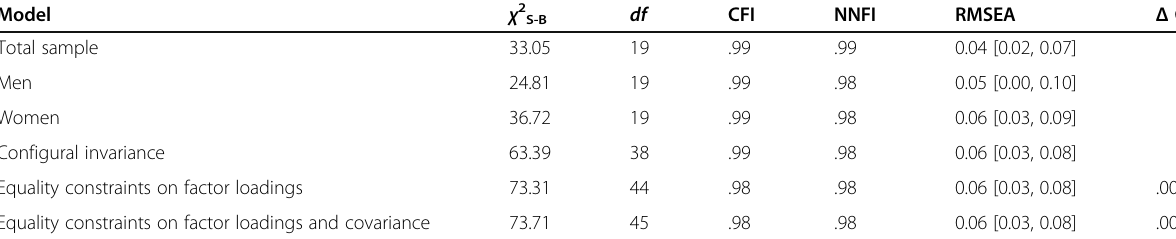
Table 3 Fit indices for the two-factor model of the PS-8 Model